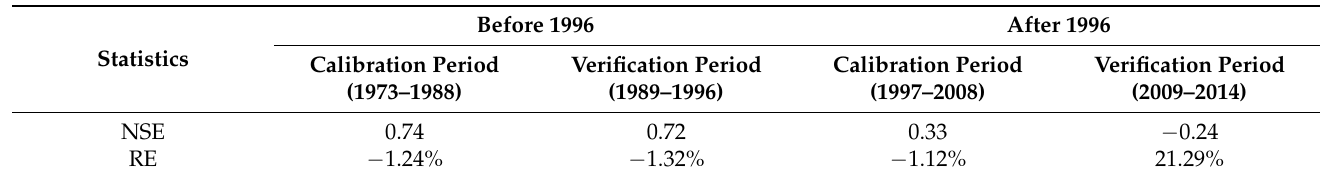
Table 4. Simulated results of the RCCC-WBM model for monthly discharge in the upper Tang River catchment.